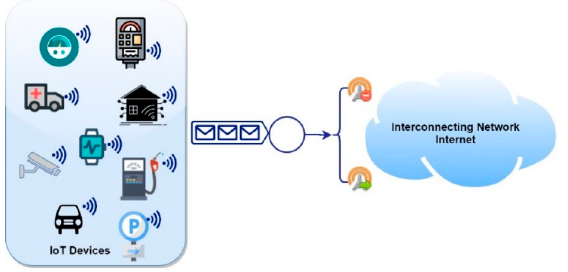
Figure 1. System under investigation.